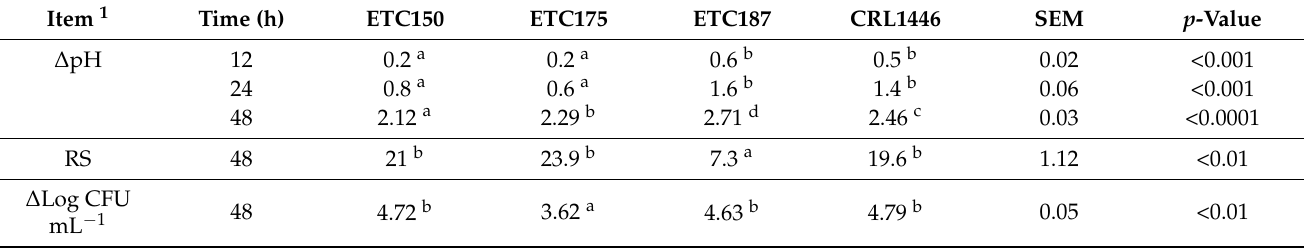
Table 3. Growth of FAE+ strains in MSFM at 30 ◦